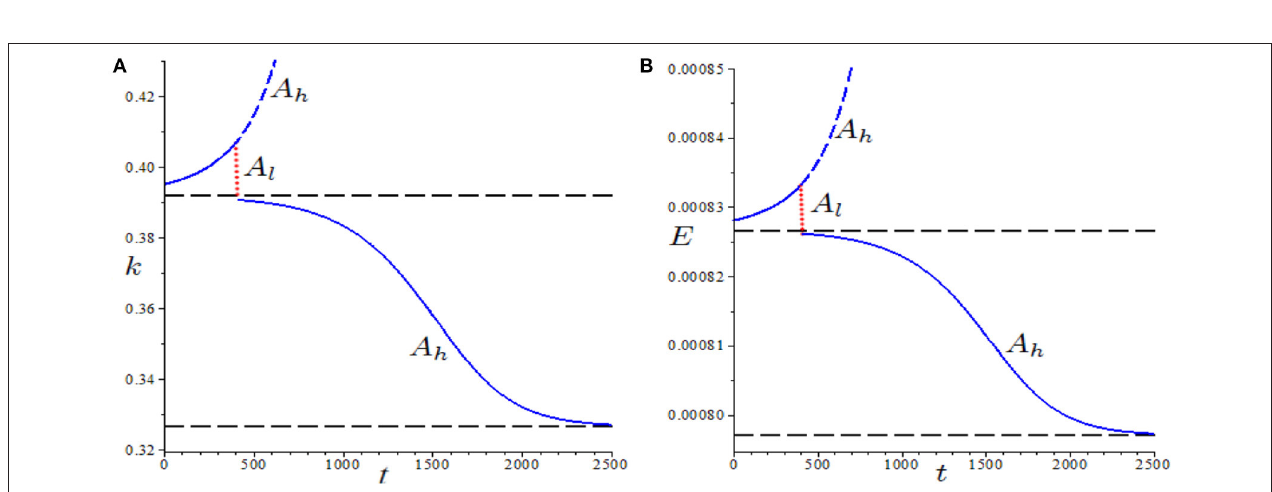
FIGURE 7 | Figure reproduced with the permission of the publisher. Source: Caravaggio and Sodini [14]. Parameter set: α = 0.32, β = 0.6, γ = 0.4, δ = 0.7, θ = 3, λ = 2.87, ρ = 0.25, σ = 0.7, τ = 0.2, φ = 0.6, E = 0.0007, A h = 48.6, A l = 48.3. (A) Evolution of capital accumulation over time when a shock in A occurs; (B) Evolution of the stock of environmental resources over time when a shock in A occurs. The red pointed vertical line represents the temporary (exactly 10 iterations) time series generated by A l